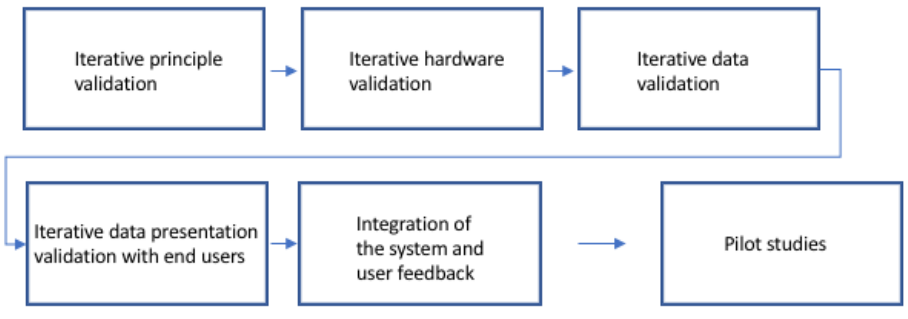
Figure 6. The retrospective view of the development process.